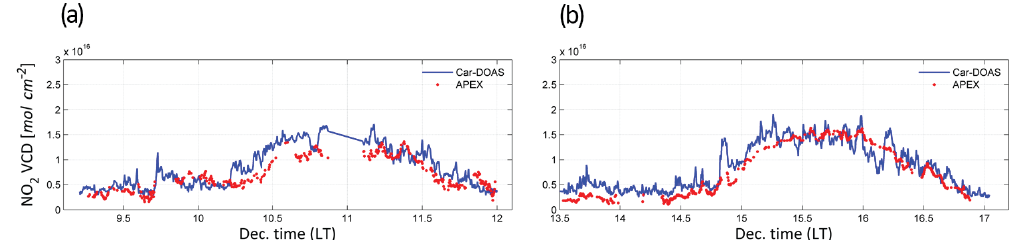
Figure 14. APEX and car DOAS NO 2 VCD time series for (a) the morning and (b) afternoon flights on 21 April 2016, respectively.